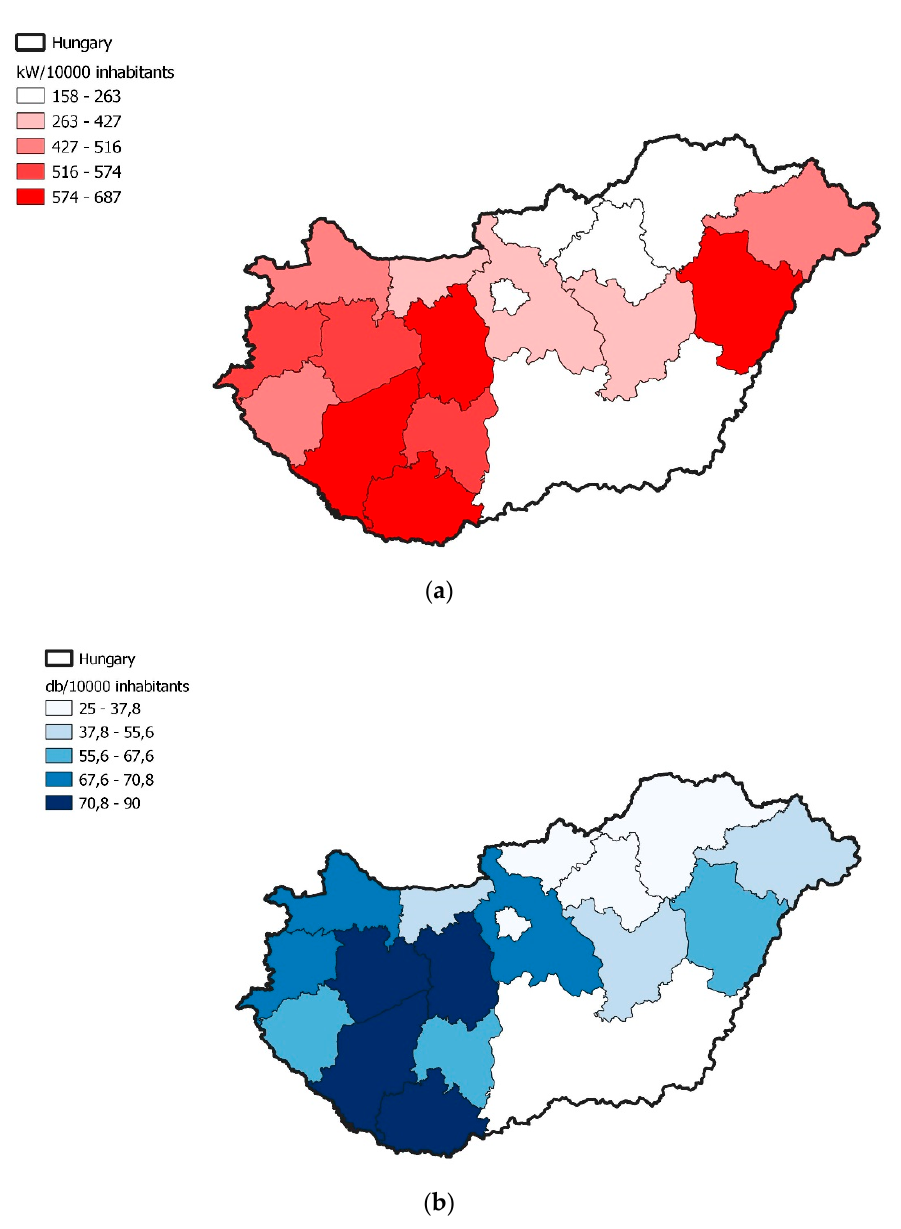
Figure 8. Total HMKE power ( a ) and the number ( b ) of HMKEs per 10,000 inhabitants in the counties of Hungary.